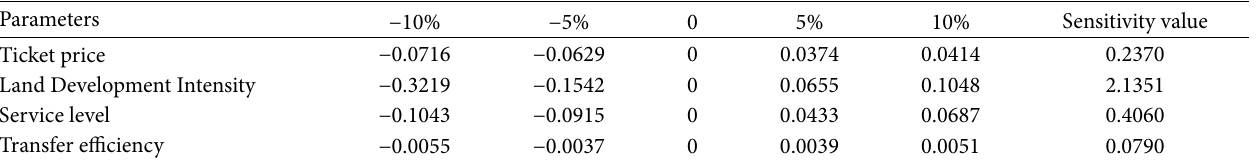
Table 2: Sensitivity test table.